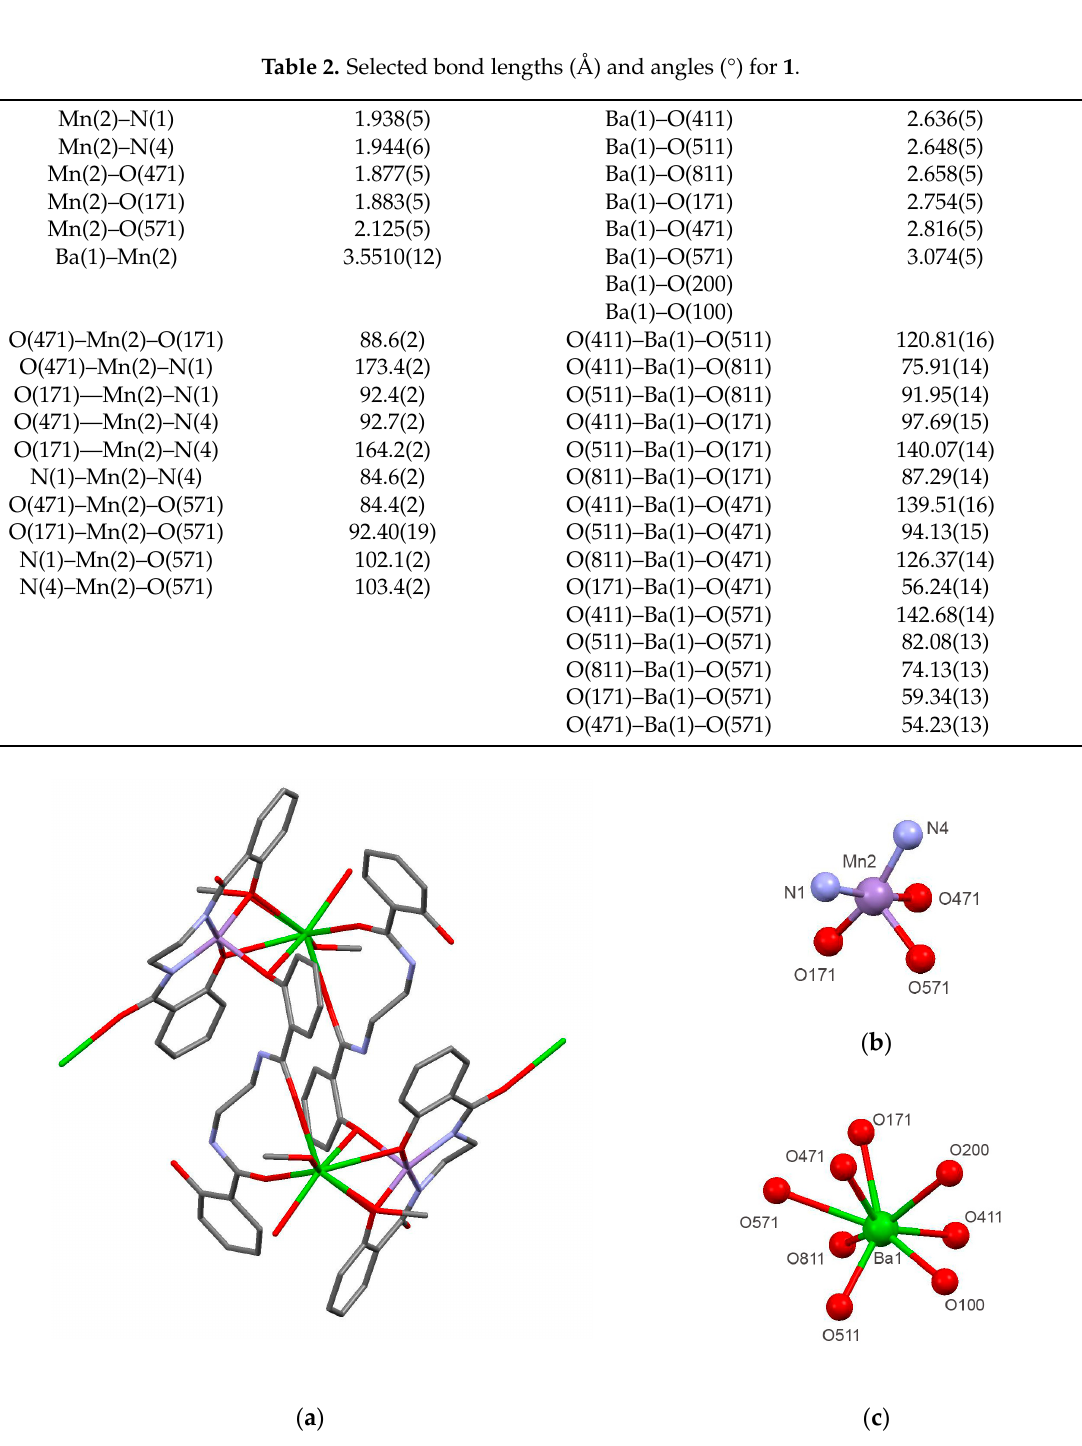
Figure 3. ( a ) Stick diagram of supramolecular box 1 (barium cation in green, manganese ion in purple, oxygen in red, nitrogen in blue, and carbon in grey); ( b ) coordination environment around the manganese center in 1 , showing the square-pyramidal geometry for this ion; ( c ) coordination environment around the barium center in 1 .